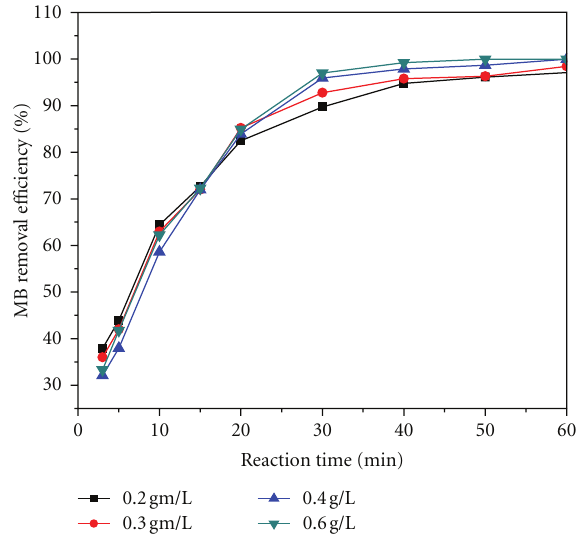
Figure 6: E ff ect of loading of optimum CeO 2 -SiO 2 sample on MB removal e ffi ciency